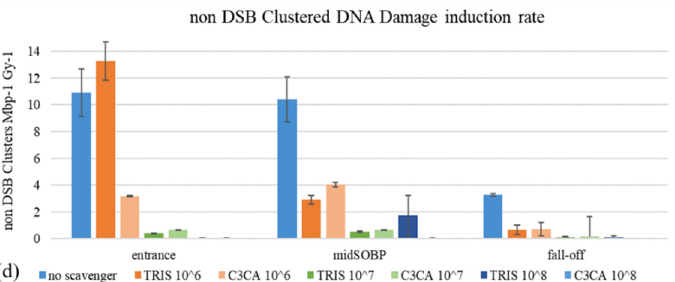
Figure 4. Proton-induced DNA damage: ( a ) Average number of SSB (SSB Mbp − 1 Gy − 1 ), ( b ) DSB (DSB Mbp − 1 Gy − 1 ), ( c ) Base Lesion and ( d ) non-DSB Clustered DNA damage induction rate versus increasing the scavenging capacity of Tris and C3CA scavengers (from 10 − 6 to 10 − 8 s − 1 ) for the three irradiation positions: the entrance of the beam (entrance), the middle of the SOBP plateau (midSOBP) and SOBP fall-off (fall-off).